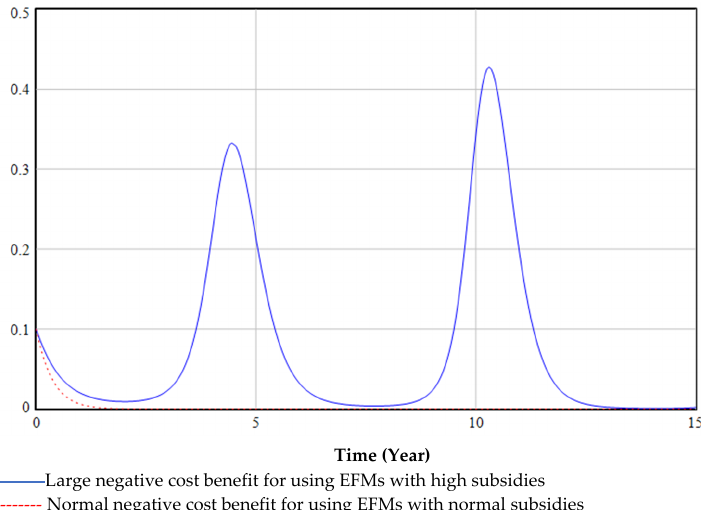
Figure 15. Different negative cost benefits for using EFMs with different subsidies.